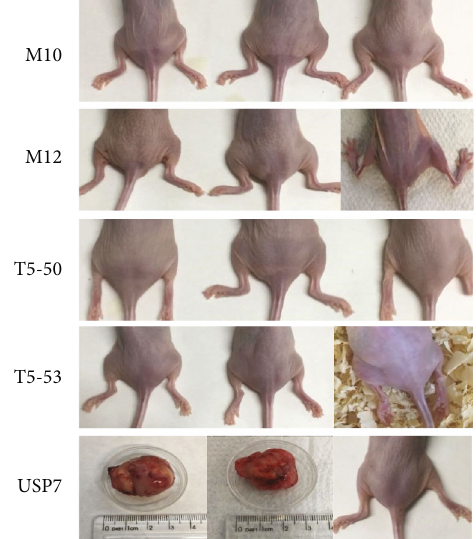
Figure 3: Tumorigenic potential of ex vivo expanded MSC. Images of tumors or fl ank region of animals at the time of euthanasia. M10 and M12: euploid human bone marrow MSC samples; T5-50 and T5-53: human bone marrow MSC samples with clonal trisomy 5; USP7: tumorigenic human ATRT cell